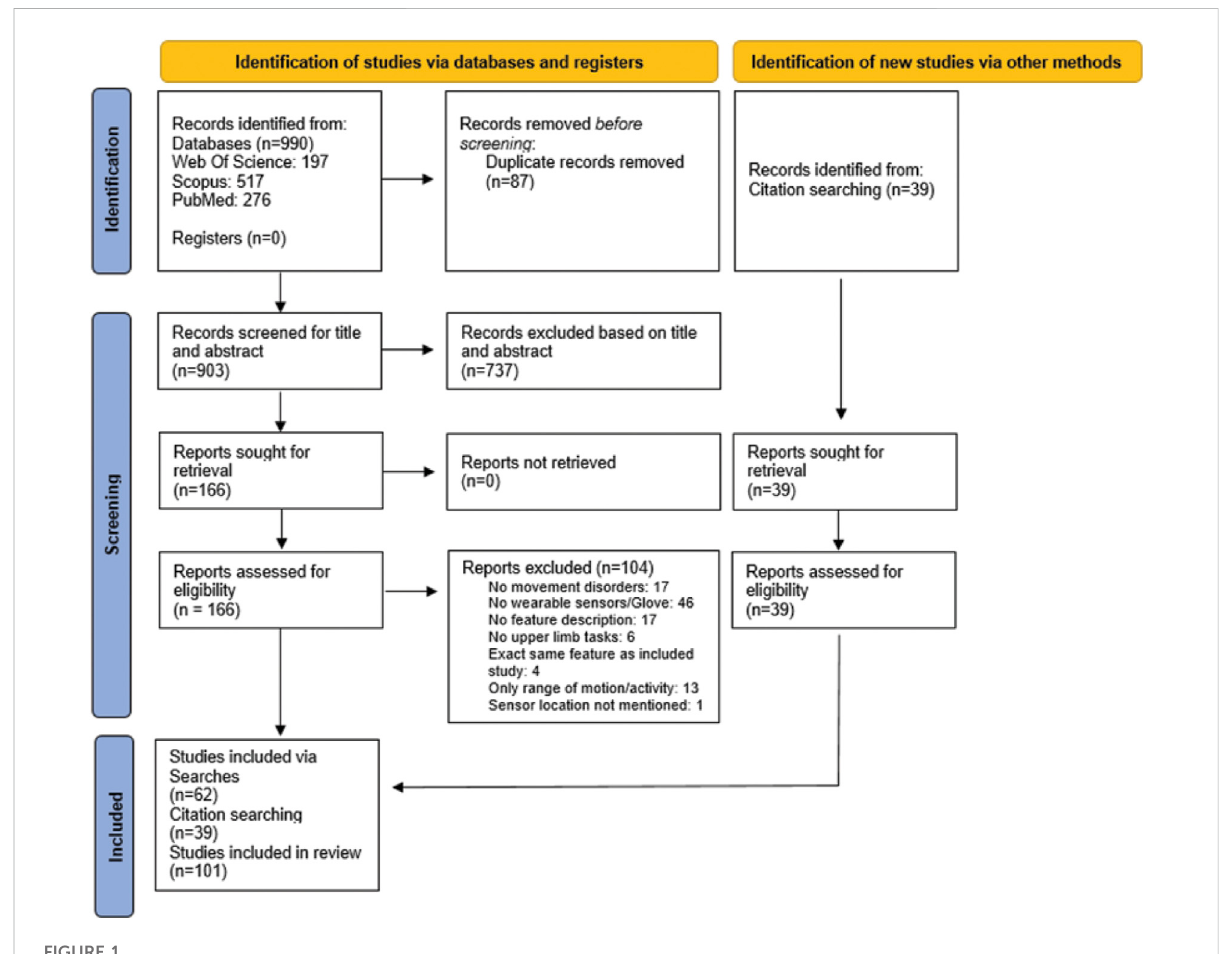
FIGURE 1 Flowchart of article